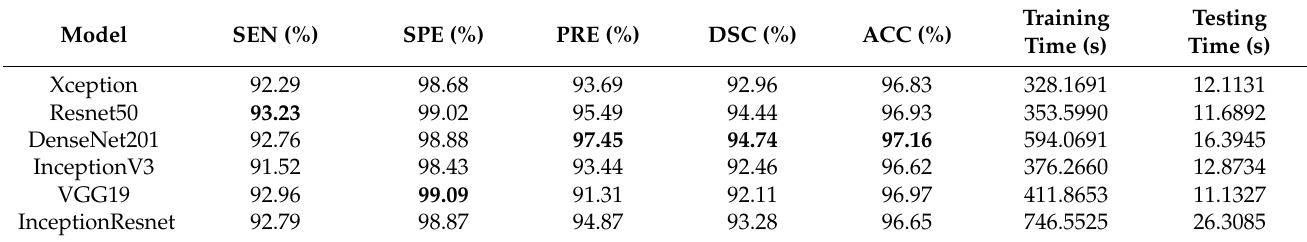
Table 4. The performance evaluation of the CNN classifiers without